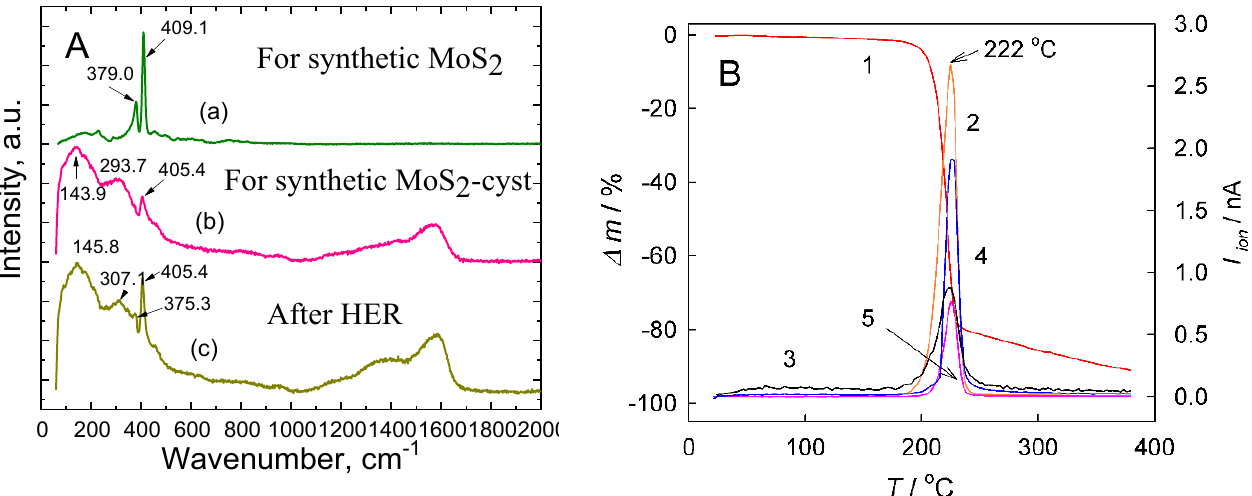
Figure 2. ( A ) Raman spectra of (a) as-grown MoS 2 and (b) MoS 2 -cys films at the Ti/TiO 2 substrate as well as (c) the same MoS 2 -cys film after the HER processing by potential cycling within a range of 0.05 to − 0.35 V vs. the RHE potential for 1000 scans; ( B ) (1) thermogravimetry (TG) plot and variables of (2) CO 2 , (3) H 2 O, (4) NH 3 , and (5) H 2 S ionic currents during annealing of L-cysteine in argon determined by mass spectrometry (MS) analysis. Solution without (a) and with 2 mmol L − 1 L-cysteine (b,c) before (a,b) and after (c) the